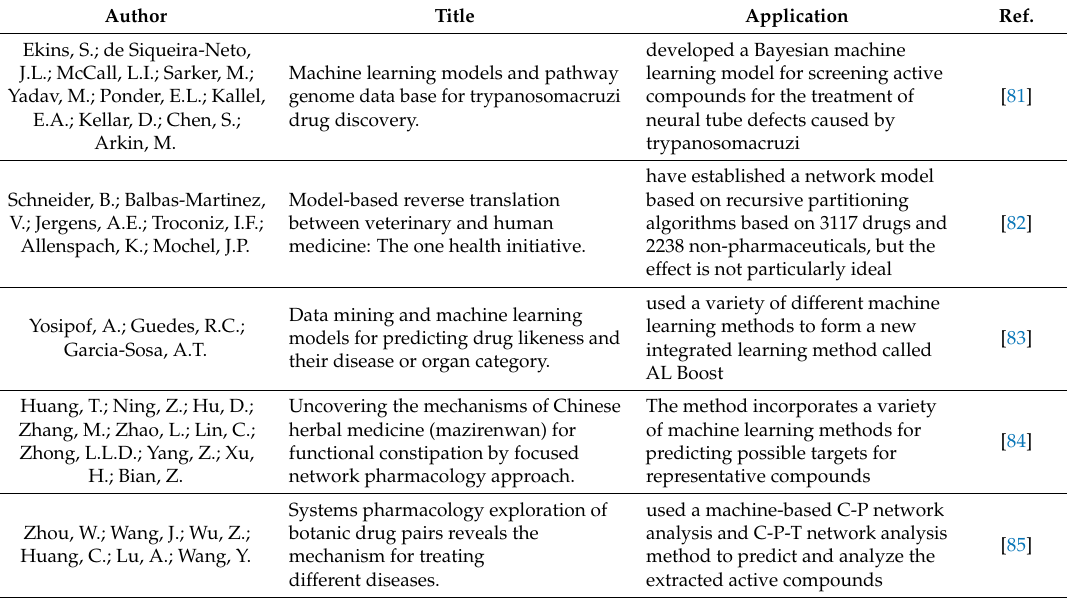
Table 3. The application examples of machine learning